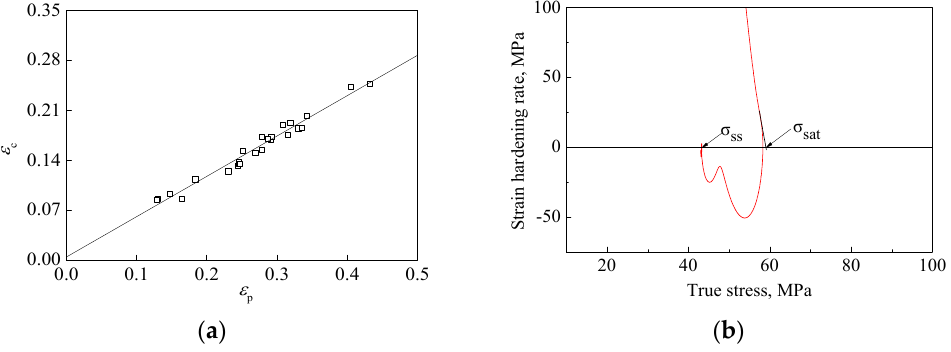
Figure 4. ( a ) Relationship between ε c and ε p ; ( b ) the true stress ‐ strain hardening rate curve at T = 1050 °C/ ε = 0.001 s − 1 .